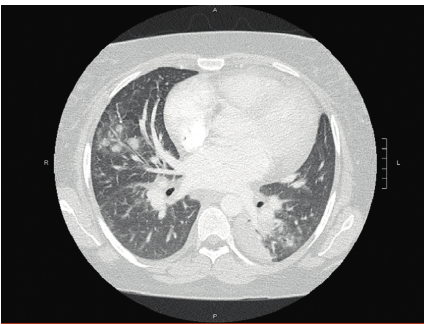
Figure 2: Computed tomography pulmonary angiogram showing no pulmonary embolism; multifocal pulmonary infiltrates; small right-sided pleural effusion; very small pericardial effusion;